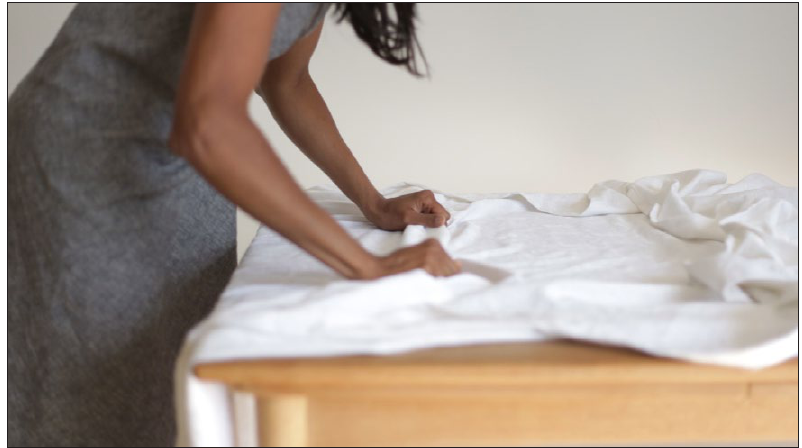
Figure 12: Farheen Haq, The Table, digital video, Video diptych, HD projector, HD player, 2015. peoples we have displaced. The teacup becomes a stand-in for the personal and the collective